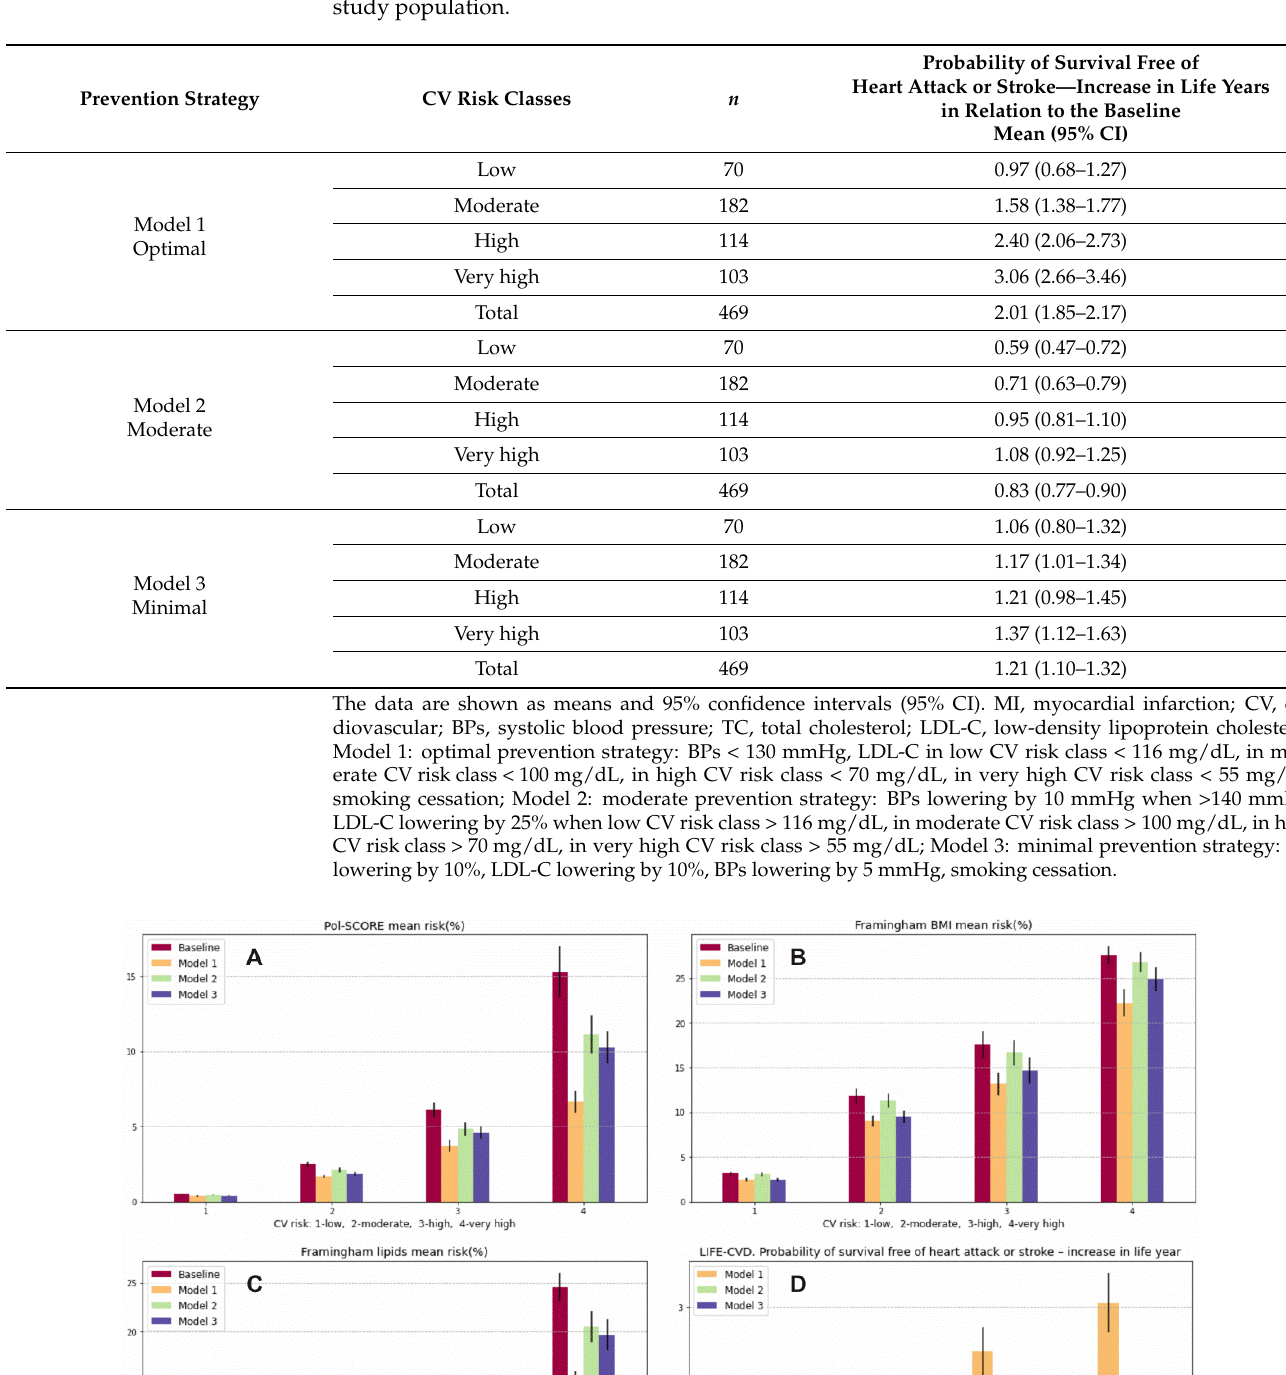
Table 4. Prediction of lifetime benefit using the lifetime-perspective model for individualizing cardio- vascular disease prevention strategies in apparently healthy people (LIFE-CVD) in the appropriate study population.